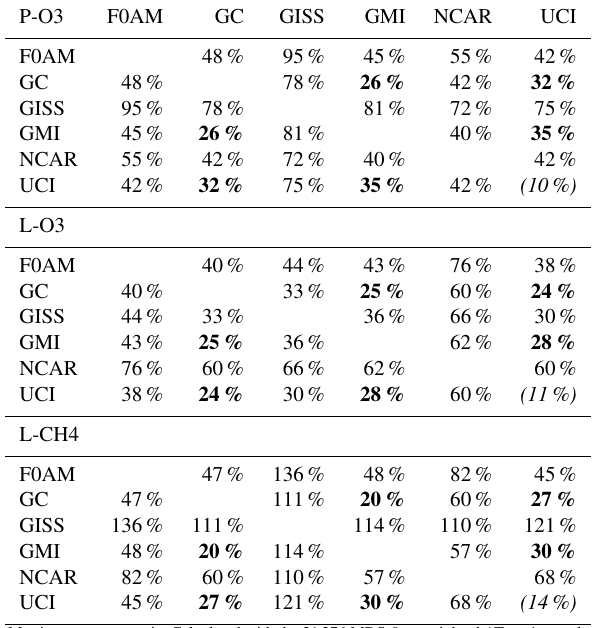
Matrices are symmetric. Calculated with the 31376 MDS-0 unweighted ATom-1 parcels using the standard RDS protocol. F0AM lacks 5510 of these parcels because there are no reported J values. UCI shows RMSD between years 2016 (default) and 1997 as the value in parentheses on the diagonal. The unweighted mean R from three core models (GC, GMI, and UCI) are P-O3 = 1.97, L-O3 = 1.50, and L-CH4 = 0.66 (all ppbd − 1 ). The three core-model RMSDs with respect to one another are less than 36% and given in